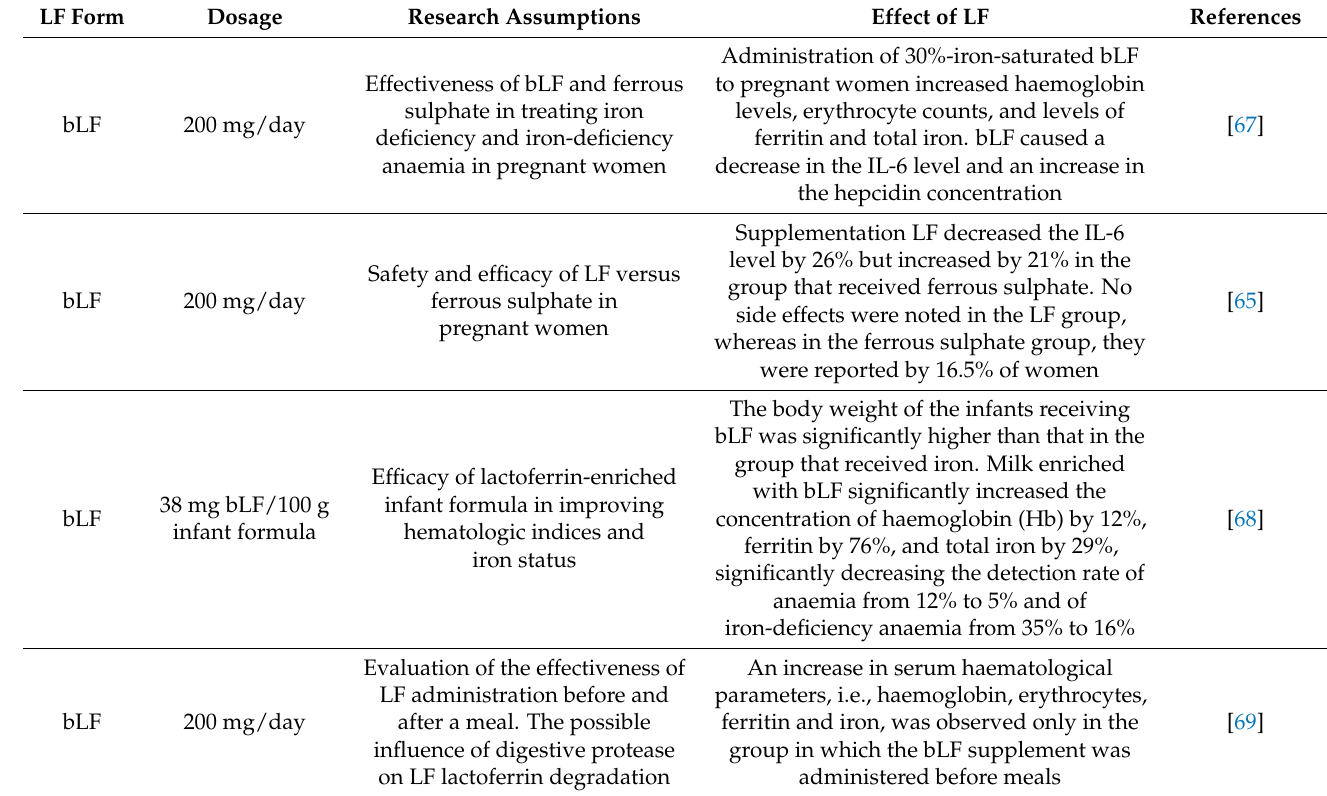
Table 2. The effect of LF supplementation on iron balance in the body (own